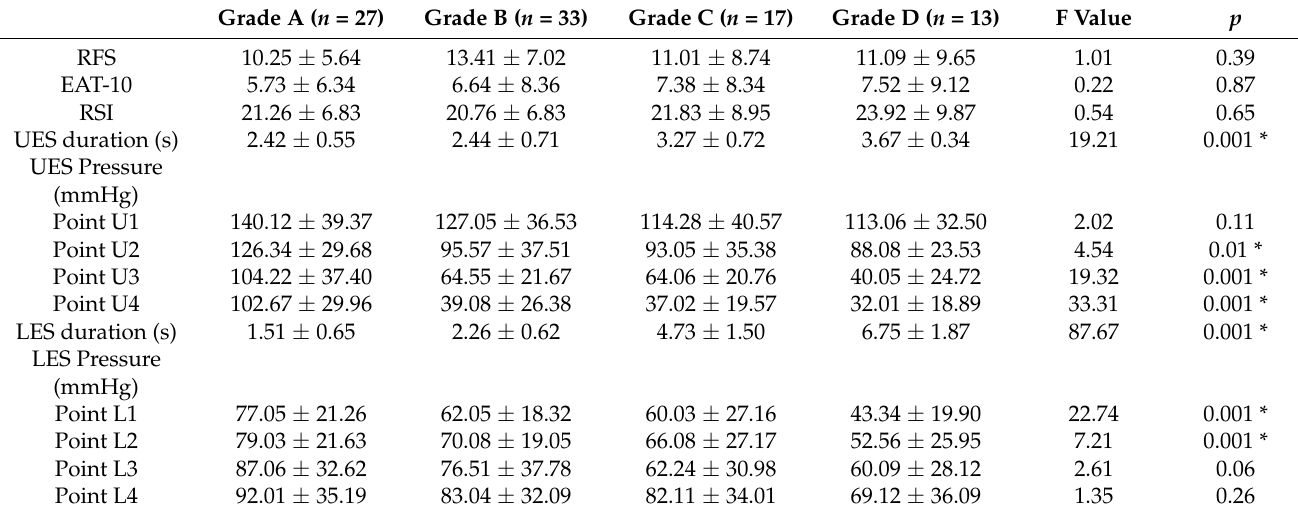
Table 2. Comparison pressure of different grades in GERD.